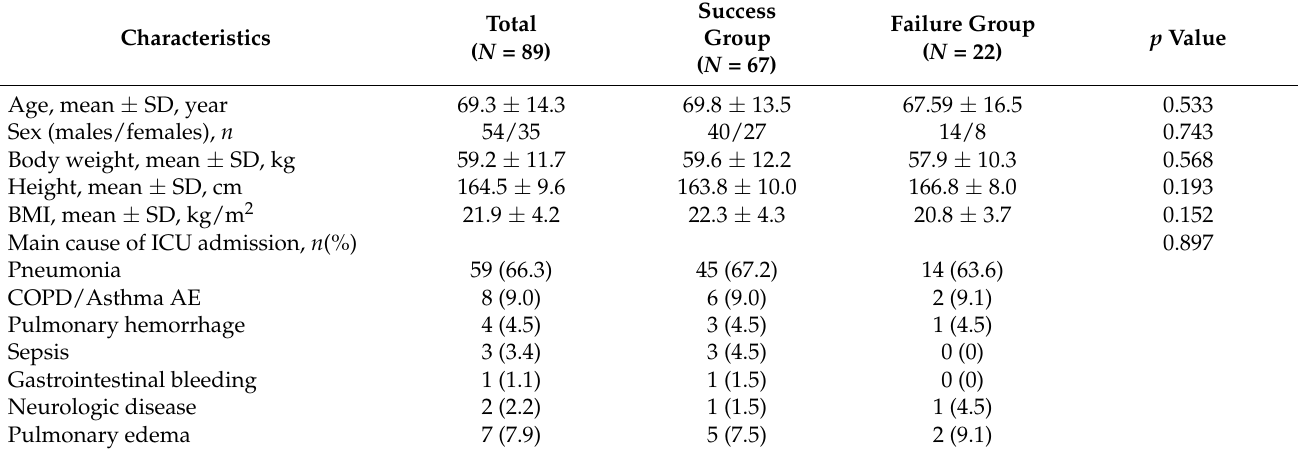
Table 1. Baseline characteristics of the study population according to the outcome of weaning.